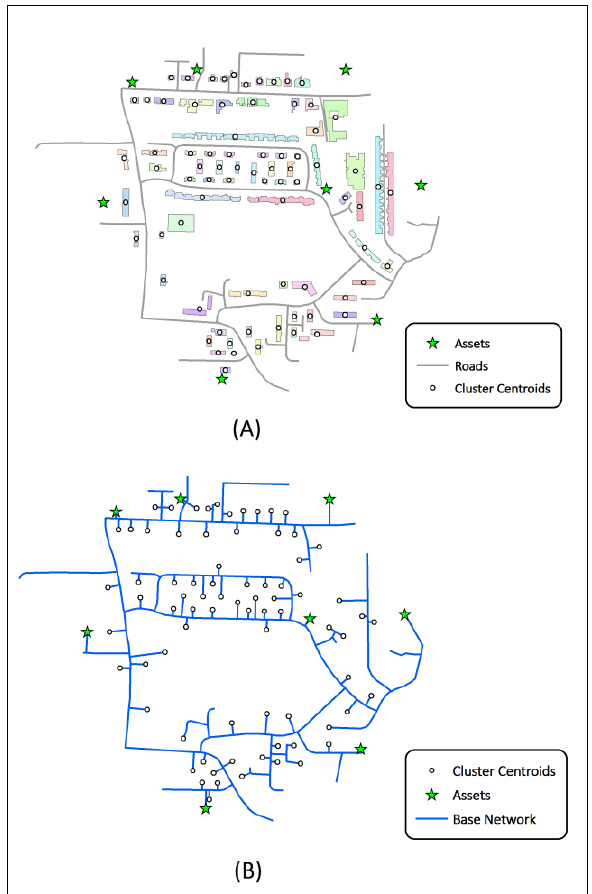
Figure 4. (A) Cluster generation on buildings. (B) Base network generation to connect assets and clusters (Contains OS data © Crown copyright and database right